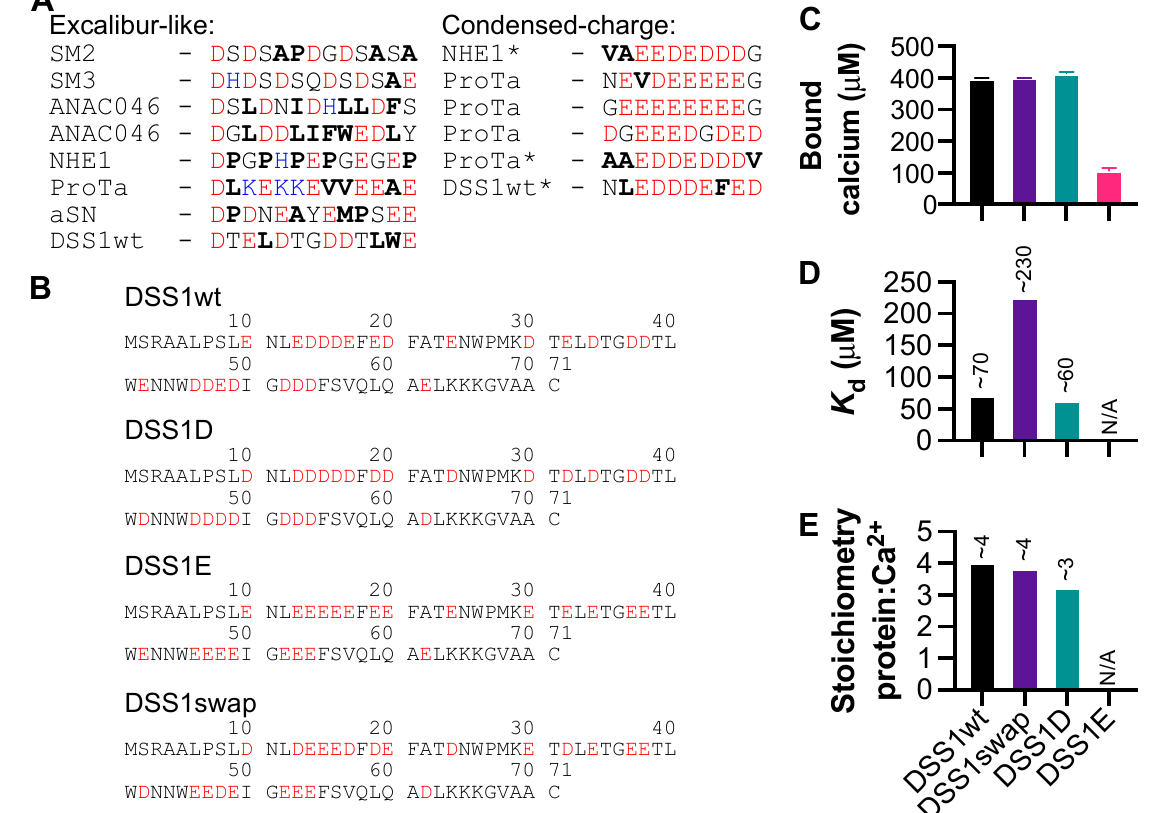
Figure 3. Narrowing down important calcium binding features in IDPs. ( A ) Two types of motifs were often associated with CSPs: the Excalibur-like sequence, involving aspartic acids distributed amongst other amino acids, in particular hydrophobic amino acids (bold); and a condensed-charge motif, which has repetitive negatively charged amino acids createing an overall high density of charge. * Indicates sequences which may fall into either category based on charge distribution. ( B ) DSS1 variant sequences. ( C ) Amount of calcium bound by each of the DSS1 mutants (100 µ M). ( D ) K d of the interaction between each protein and Ca 2+ . ( E ) Stoichiometry of the interaction between each protein and Ca 2+ . Error bars indicate